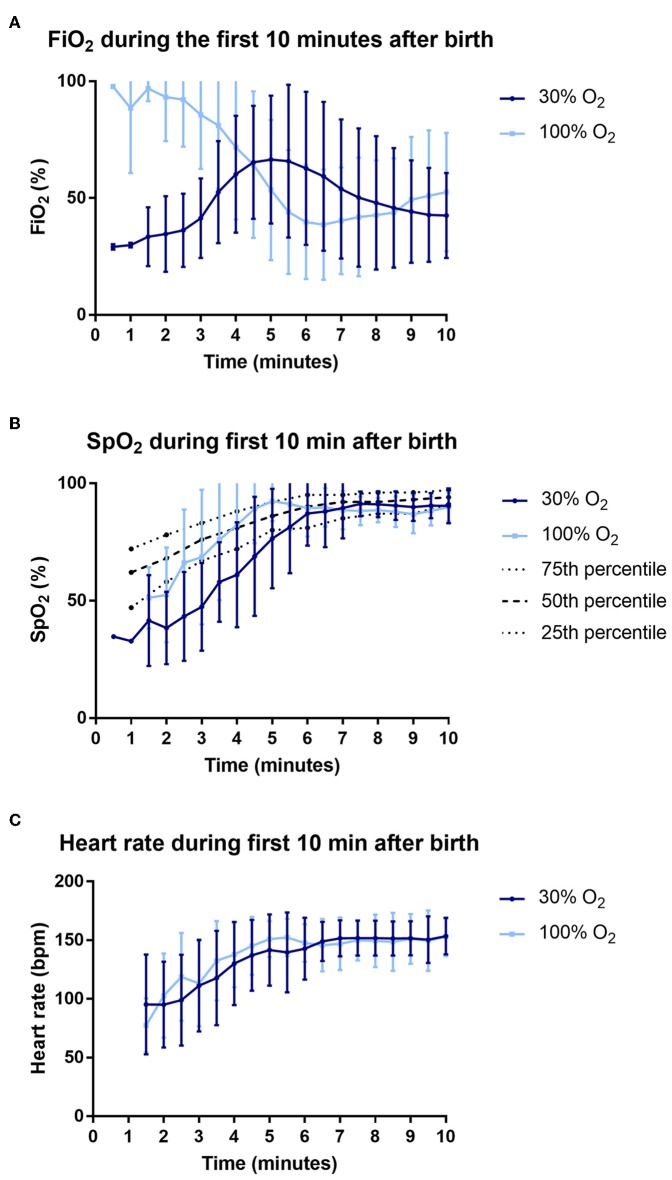
Data on fraction of inspired oxygen (FiO2) (A), oxygen saturations (SpO2) (B) and heart rate (C) during the first 10 min after birth.